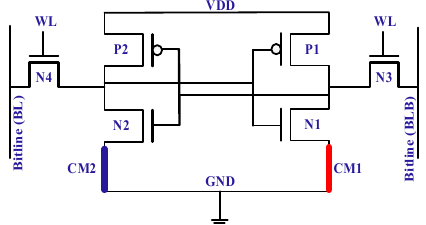
Figure 13. Correlated material-based 6T-SRAM cell [51].